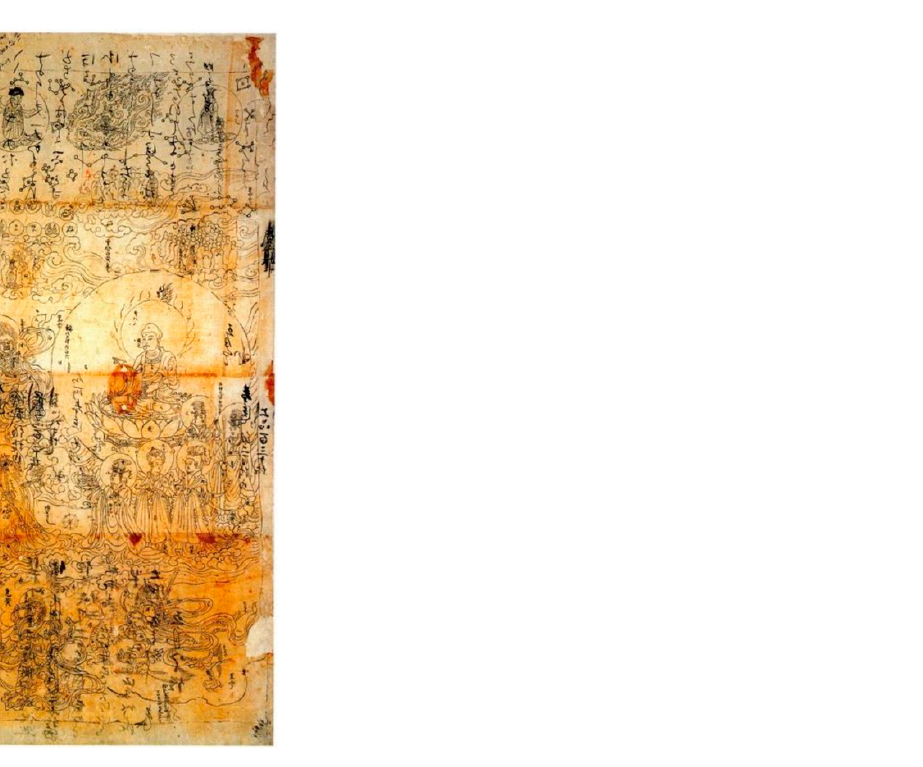
Figure 9. Tangben beidou mantuluo zhiben mohua 唐本北斗曼荼羅紙本墨畫 (Tang Dynasty Ink Painting on paper of the Mandala of the Northern Dipper), The University Art Museum, Tokyo University of the Arts, 111.5 cm × 51.5 cm, 1148.